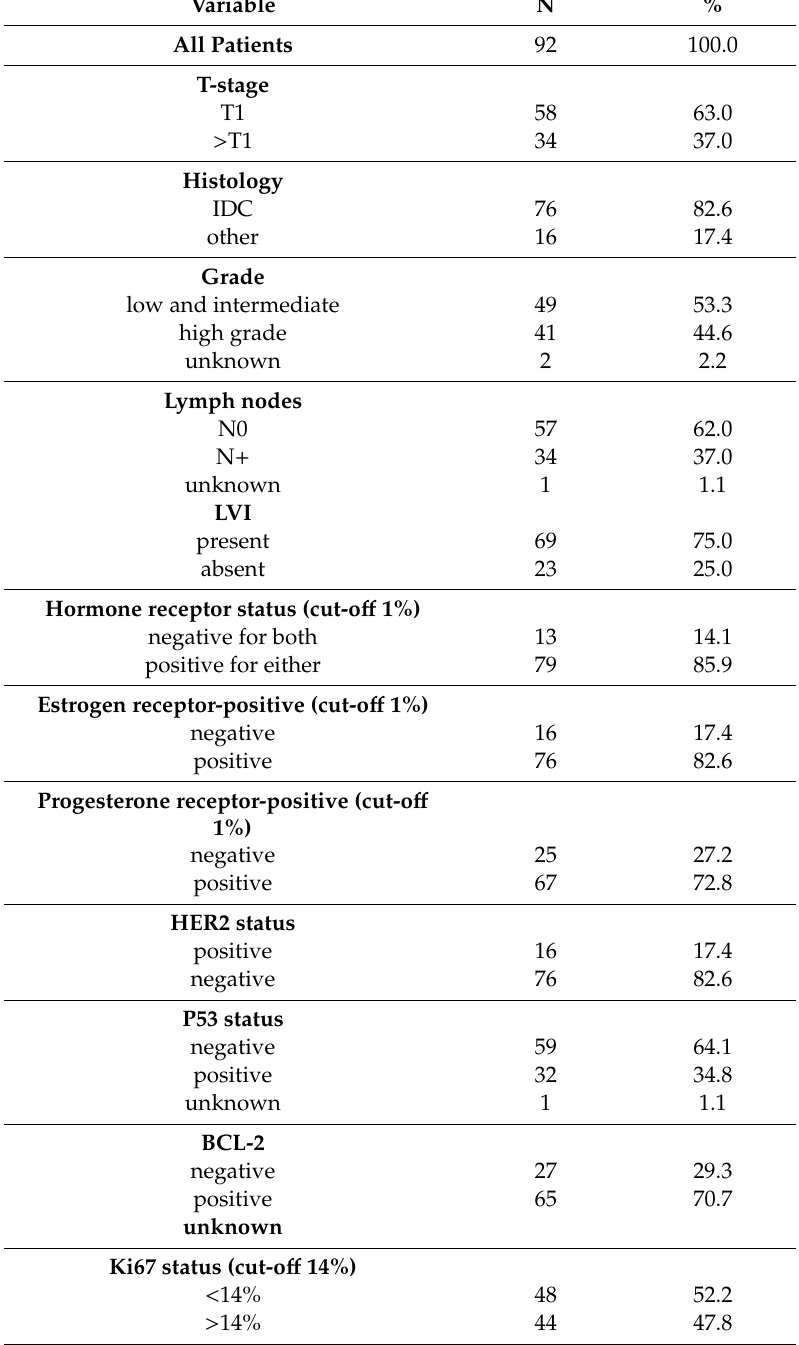
Table 1. Patients’